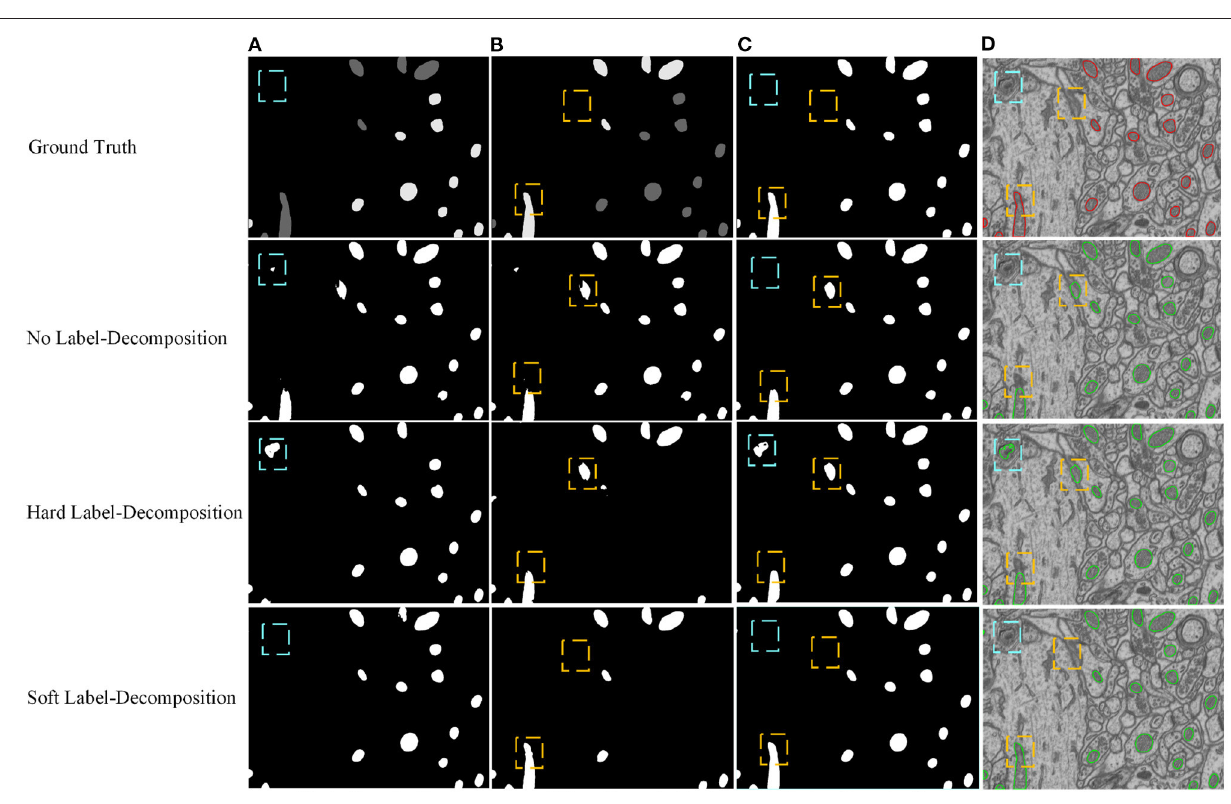
FIGURE 8 | Visual comparison of predictions of the circle decoder and ellipse decoder in the first stage and the fusion decoder in the second stage. The results of the HED-Net with no label-decomposition, hard label-decomposition, and soft label-decomposition are reported. (A) Circle decoder pred., (B) ellipse decoder pred., (C) fusion decoder pred., (D) overlaid